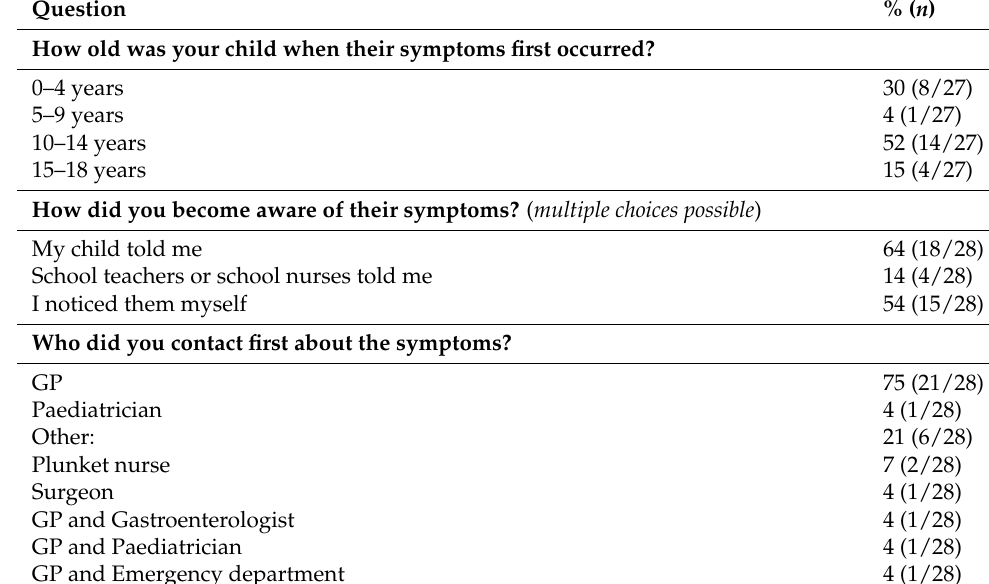
Table A3. Parent/caregiver questionnaire: Symptoms and disease course.